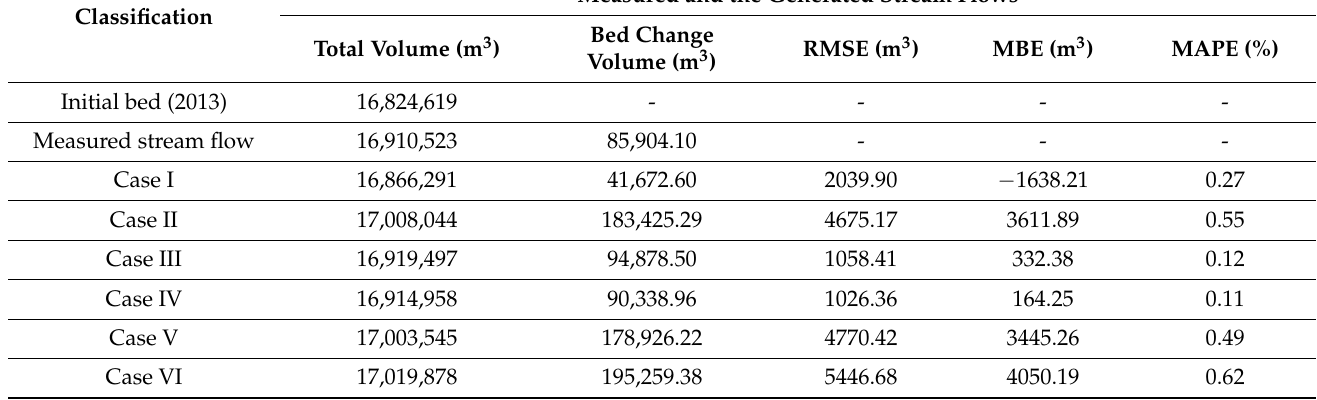
Table 6. Total volume of river bed change and errors between the measured and the simulated both using the surveyed and six scenarios. Errors for Volume of Bed Changes between the Measured and the Simulated Both Using the Measured and the Generated Stream